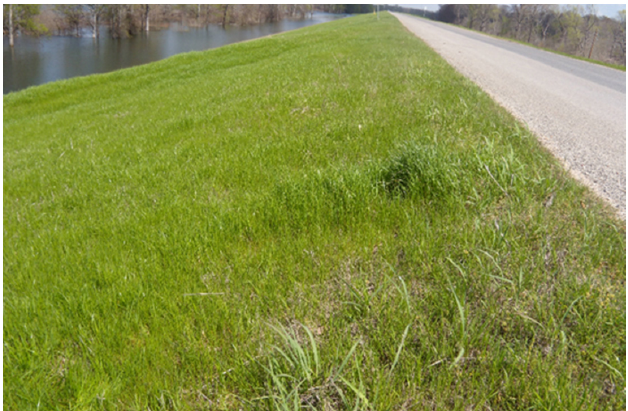
Figure 1. Earthen levee at Eagle Lake, Warren County, Vicksburg, MS, USA.